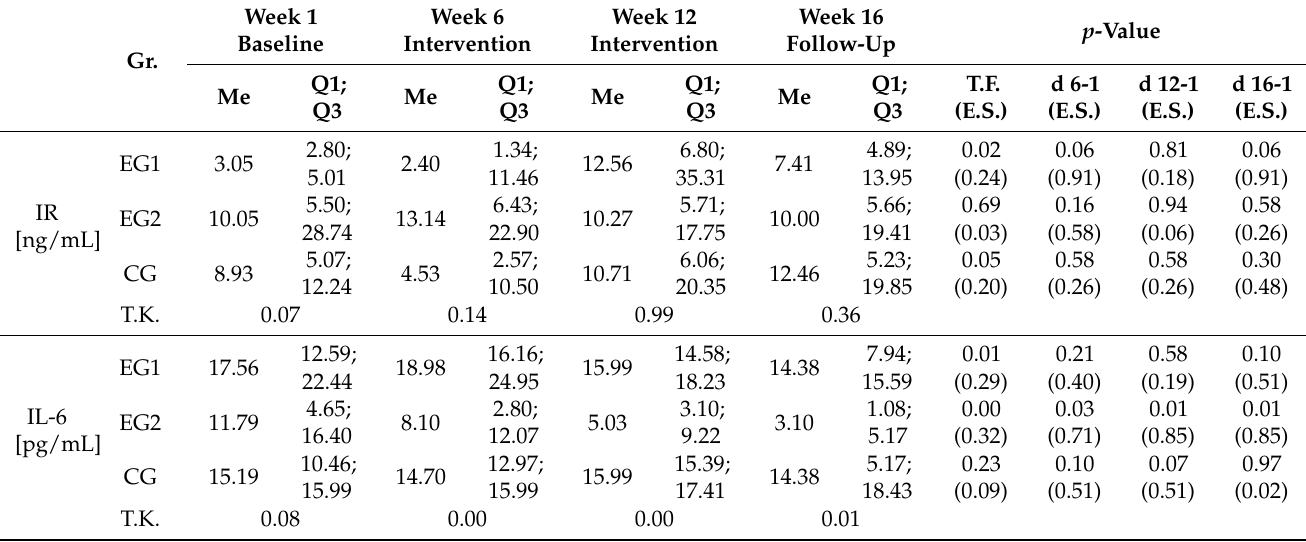
Table 6. Concentrations of irisin (IR) and interleukin-6 (IL-6) in participants’ blood plasma in the aerobic group (EG1), aerobic-resistance group (EG2), and control group (CG).